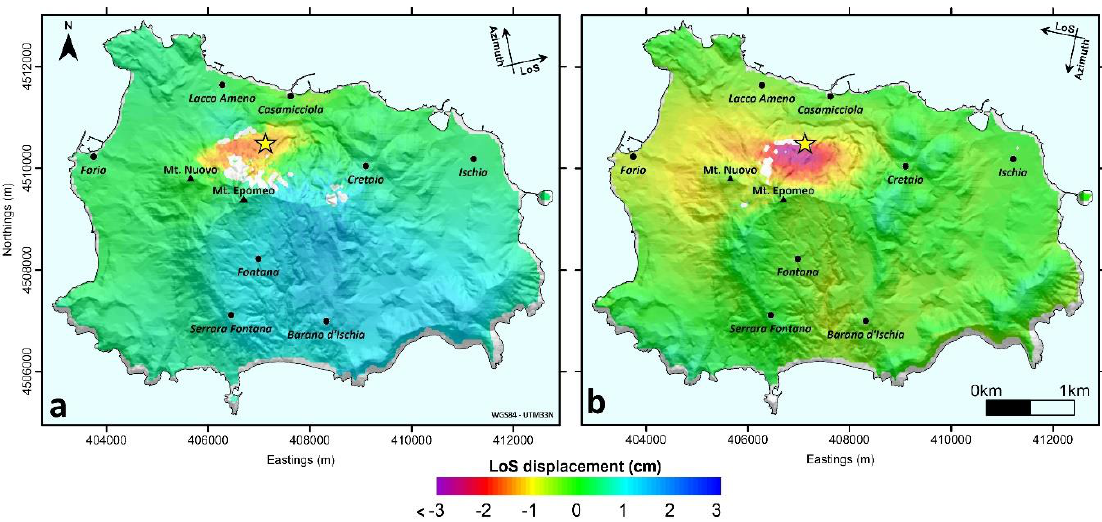
Figure 4. Coseismic displacement maps from S1 SAR data of the Ischia earthquake. ( a ) Line of sight (LoS) displacements along the ascending orbit; ( b ) LoS displacements along the descending orbit. The yellow star identifies the Ischia earthquake epicenter.